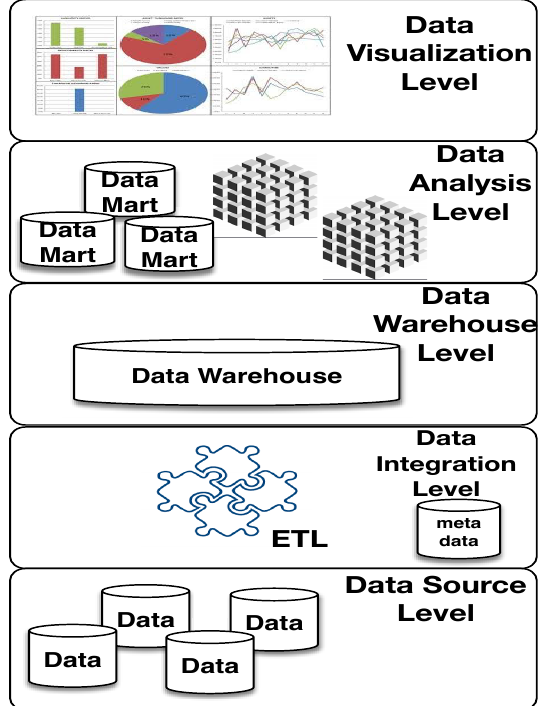
Figure 2. The COVID-WAREHOUSE architecture, implemented as 5 independent and cooperating